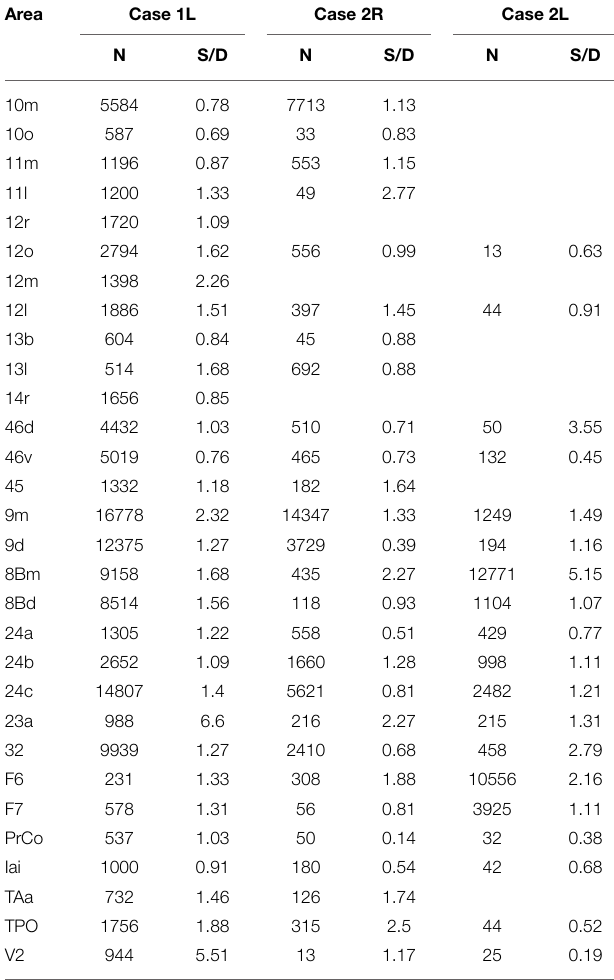
TABLE 1 | Total number of labeled neurons (N) and the ratio of the number of labeled neurons in superficial layers (layers 1–3) to the number of labeled neurons in deep layers (layers 5 and 6) (S/D) in each cortical